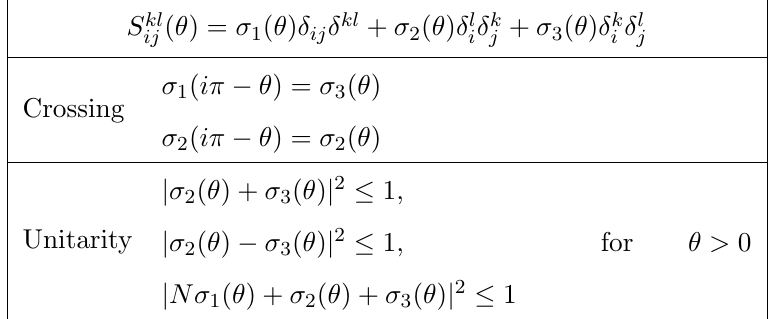
Table 1 . Crossing and unitarity for the S-matrix in the component decomposition (2.2). Crossing simply re-shu(cid:15)es the functions in this language but unitarity is more